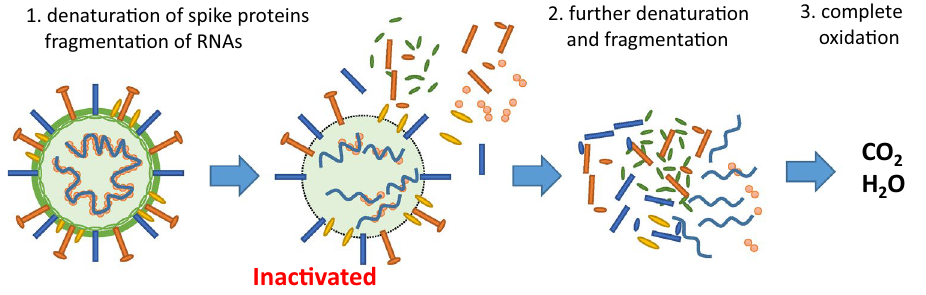
Figure 6. Speculated antiviral mechanism of Cu x O/TiO 2